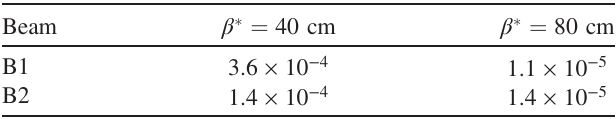
TABLE V. SIXTRACK predictions of the fraction of total losses that end up on the TCTs in IR1 for the machine configurations during the loss-map tests of this study: β (cid:1) ¼ 80 cm with TCTs at 13 . 7 σ as in 2015 operation, and β (cid:1) ¼ 40 cm with TCTs at 8 . 8 σ , where the latter is also close to the 2016 configuration for physics operation. The presented values are the ratio of total losses on the horizontal and vertical TCTs with respect to all halo related losses around the machine.